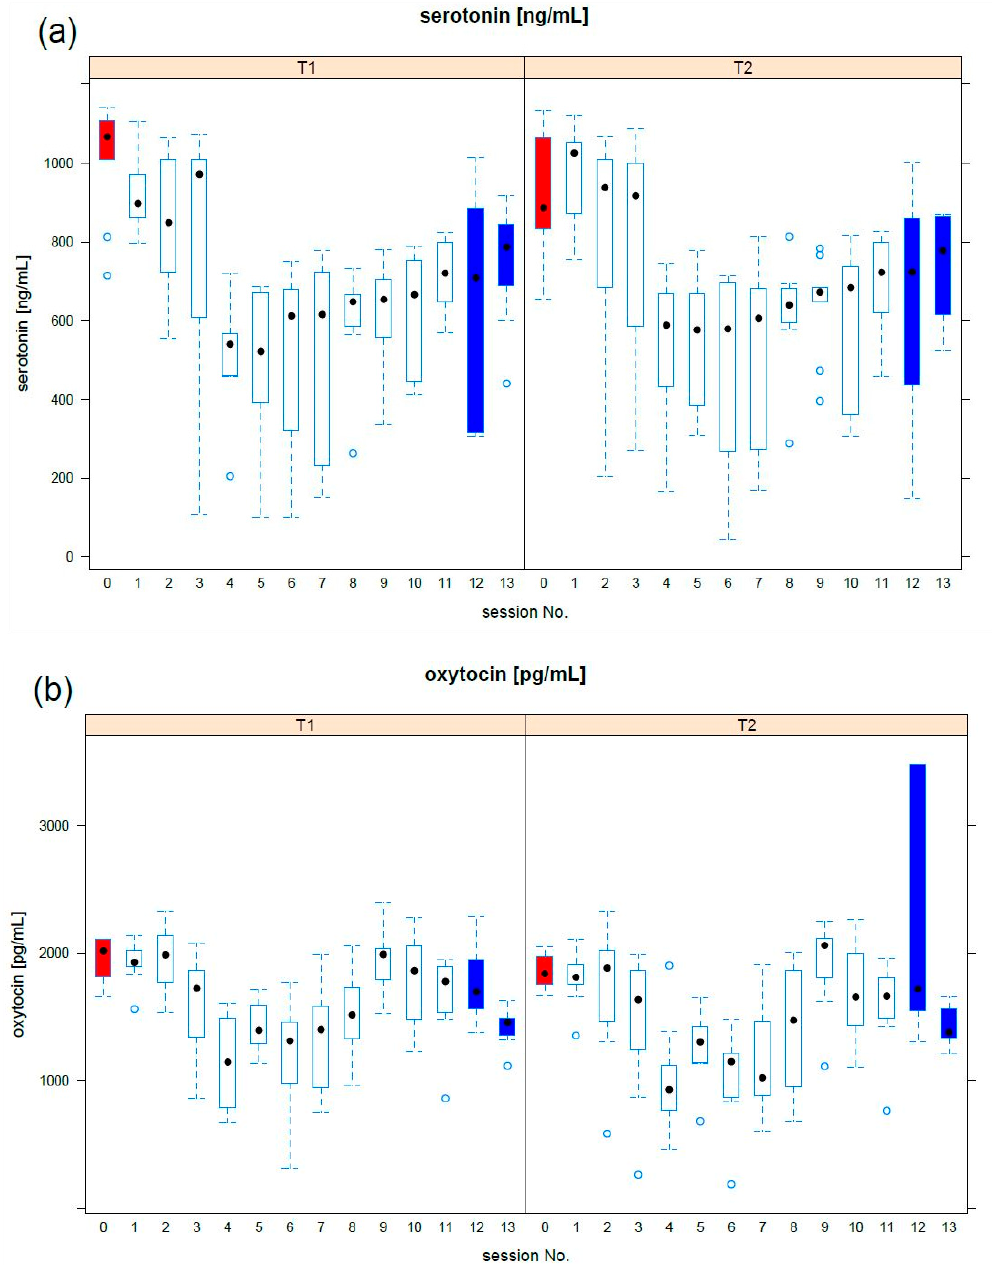
Figure 1. Mean profiles response at T1 and T2: the boxplot of ( a ) serotonin, ( b ) oxytocin was reported per each meeting. The preliminary meeting (red) established basal levels, while the last two meetings (blue) provided information on the long-period e ff ect. Median values are indicated by a black dot. For the first phase, there was no clear evidence that both random intercept and slope fitted data were better than the fixed slope and the random intercept (AIC = 493, BIC = 499, p < 0.05): fixed slope = − 135 (ng / mL) / week, fixed intercept = 1103 ng / mL, standard deviation of random e ff ect = 150 ng / mL. For the second phase, the best explanation (AIC = 832, BIC = 845, p < 0.05) was that from both the random intercept and slope models, the fixed intercept = 327 ng / mL, the fixed slope = 31.4 (ng / mL) / week; the standard deviation of random intercept = 275 ng / mL, and the random slope = 17.3 (ng / mL) /